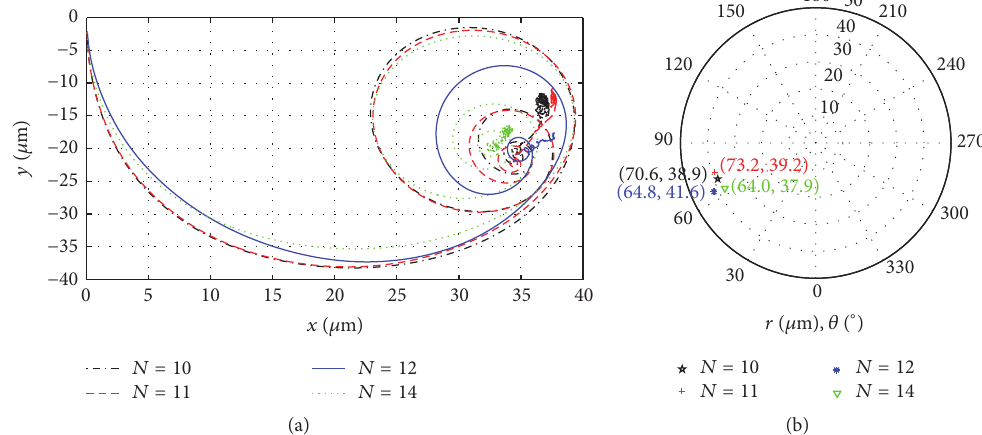
Figure 14: (a) Rotor trajectory and (b) polar coordinates of the HGGJB under different groove numbers at the rotating speed of 10000 r/min.